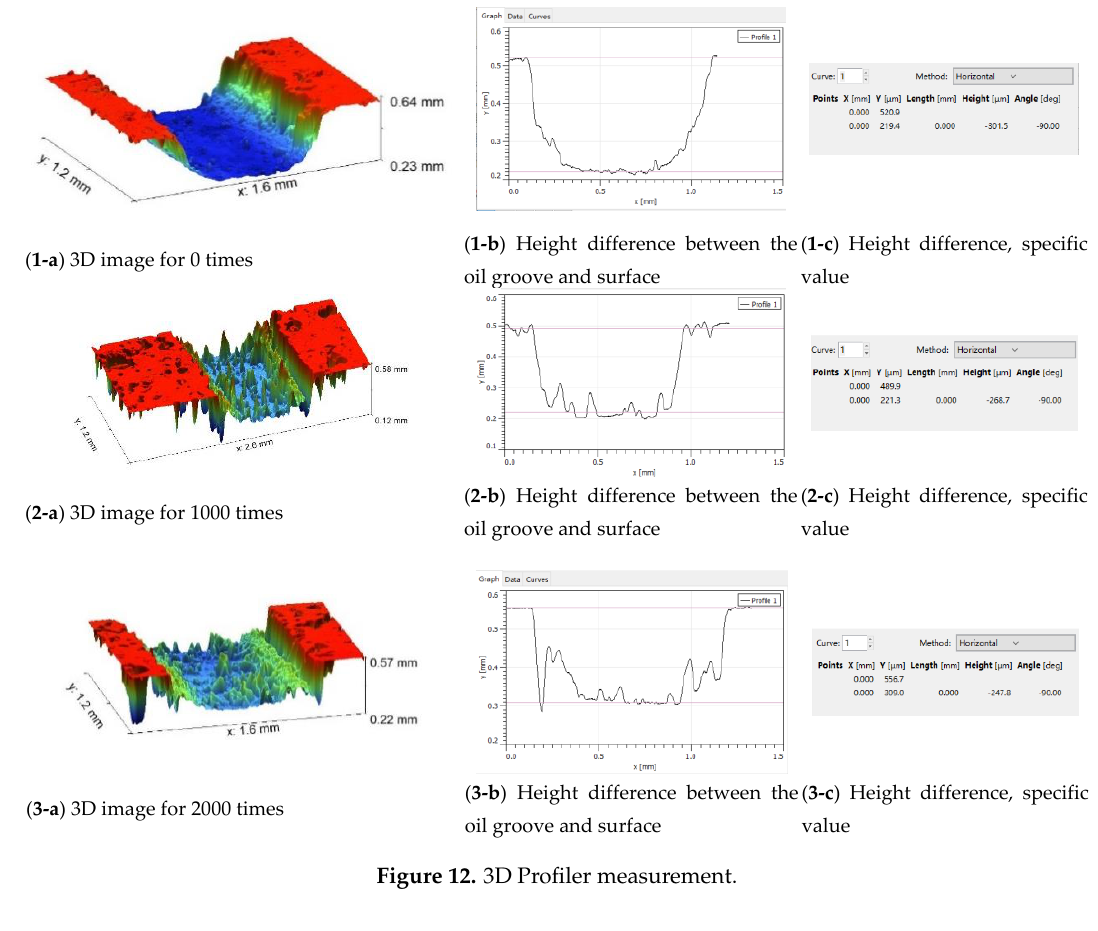
Figure 12. 3D Profiler measurement.